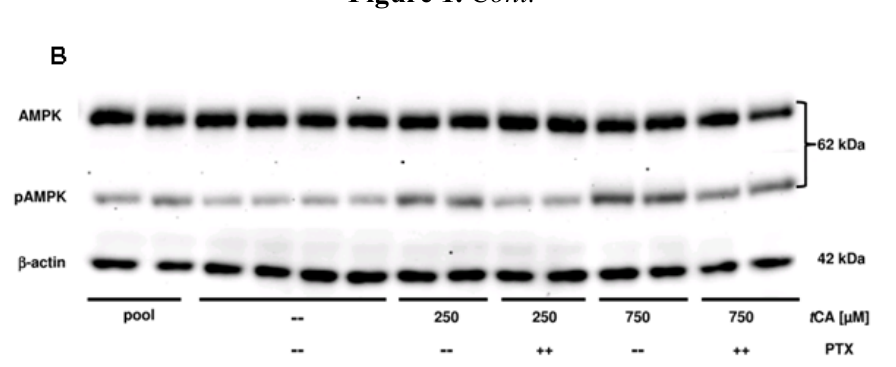
Figure 2. Trans -cinnamic acid ( t CA) effects on AdipoQ concentrations in cell